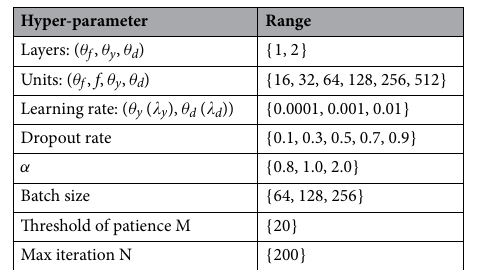
Table 3. Hyperparameter evaluated in the proposed